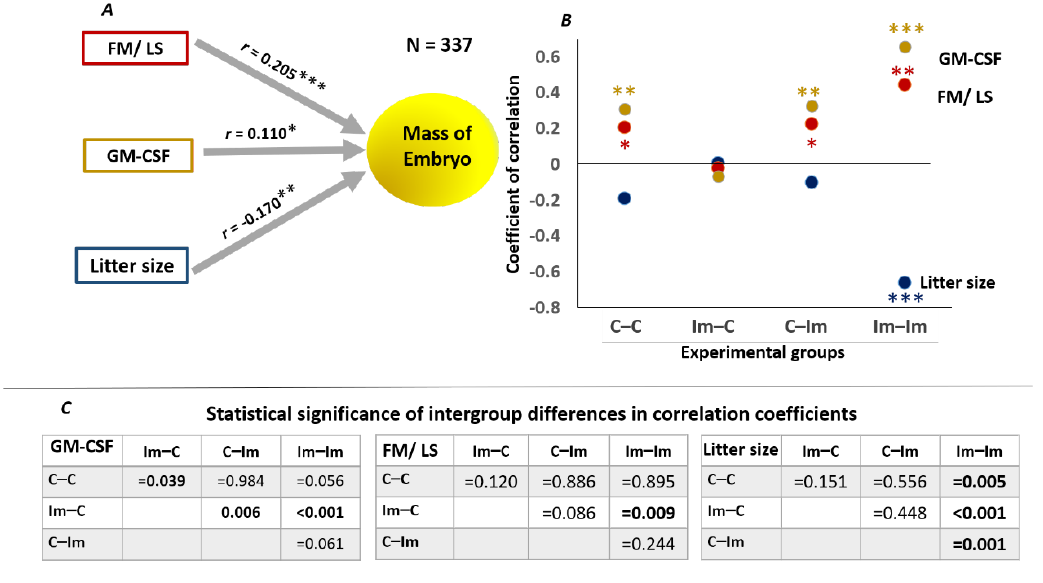
Figure 5. Correlation of embryo mass with maternal resource traits. ( A ) Coefficients of correlation for the whole data set ( n = 337) of per-embryo female mass (female mass/litter size—FM/LS), litter size, and amniotic fluid GM-CSF (pg/mL) with embryo mass on day 16 of pregnancy. ( B ) Coefficients of correlation for the different experimental groups of FM/LS (red points), litter size (blue points), and amniotic fluid GM-CSF (yellow points). Significance of correlation coefficients in ( A , B ): * p < 0.05; ** p < 0.01; *** p < 0.001. ( C ) Statistical assessments of intergroup differences between coefficients of correlation ( p -values were calculated with Student’s t -test).